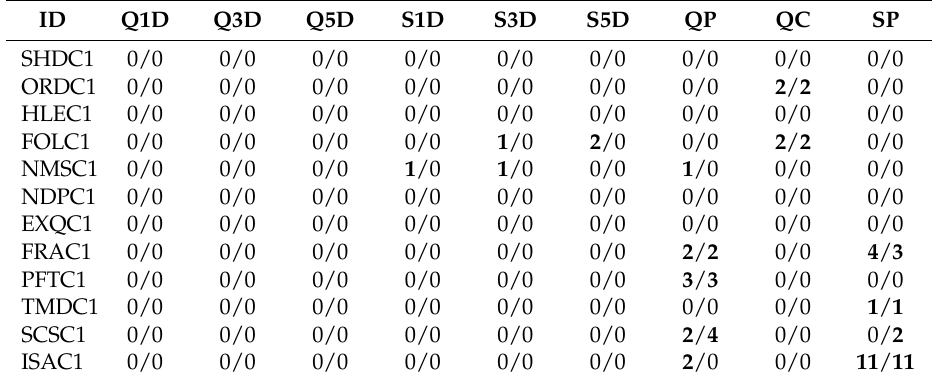
Table 8. Number of 30-year periods showing significant trends via the MKT and linear regression methods 1